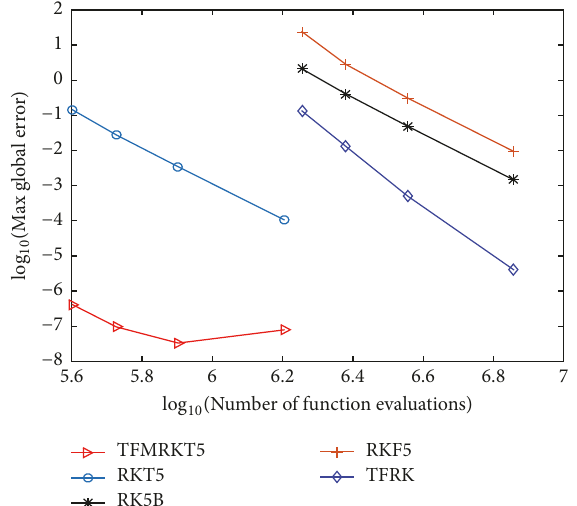
Figure 9: Plot of graph for function evaluations against step size ℎ for Problem (58) taking 𝑥 𝑒𝑛𝑑 = 1 , ℎ = 0.1, 0.01, 0.001, 0.0001 , and 𝑘 = 2 .